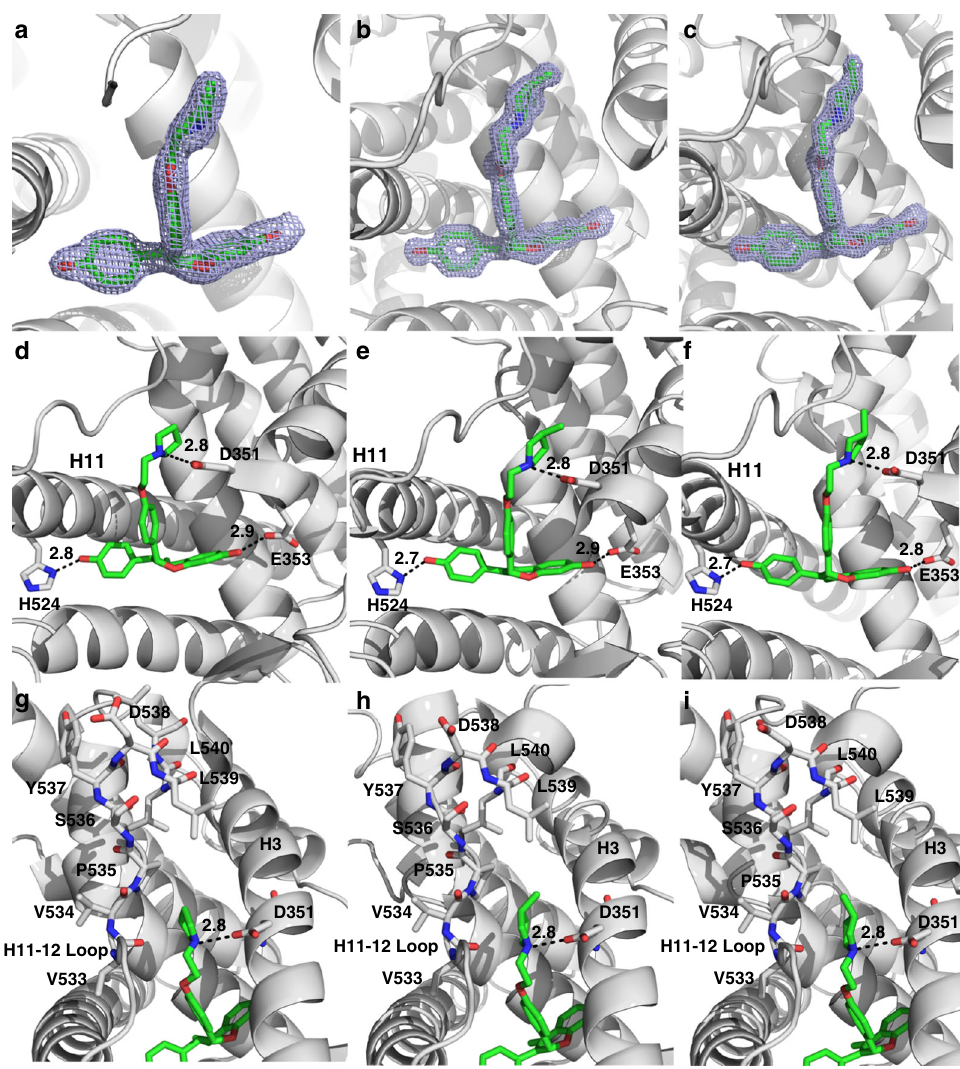
Fig. 5 X-ray crystal structure analysis of OP compounds bound to ER α LBD. a – c , Simulated annealing composite omit maps contoured to 1.5 σ for OP-1156 ( a ), OP-1154 ( b ), and OP-1074 ( c ). d – f , Hydrogen bonds formed between OP-1156 ( c ), OP-1154 ( d ) and OP-1074 ( e ) and ER α LBD. Helices 3 and 11 are denoted as H3 and H11 respectively. g – i Enhanced view of OP-1156, OP-1154, and OP-1074 near the H11-12 loop which ultimately perturbs H12 leading to